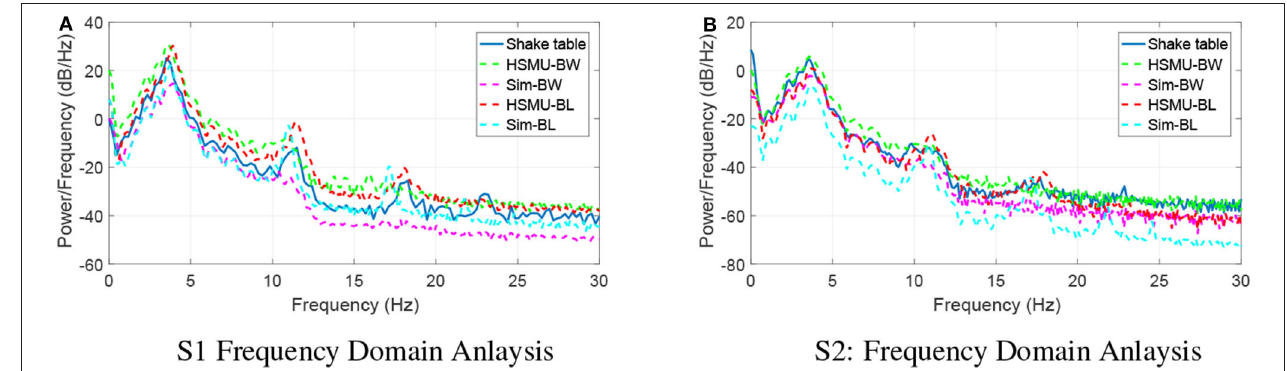
Frontiers in Built Environment |